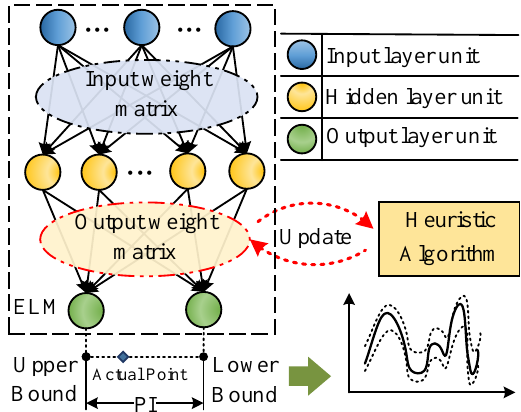
Figure 1. The schematic diagram of the lower and upper bound estimation (LUBE)